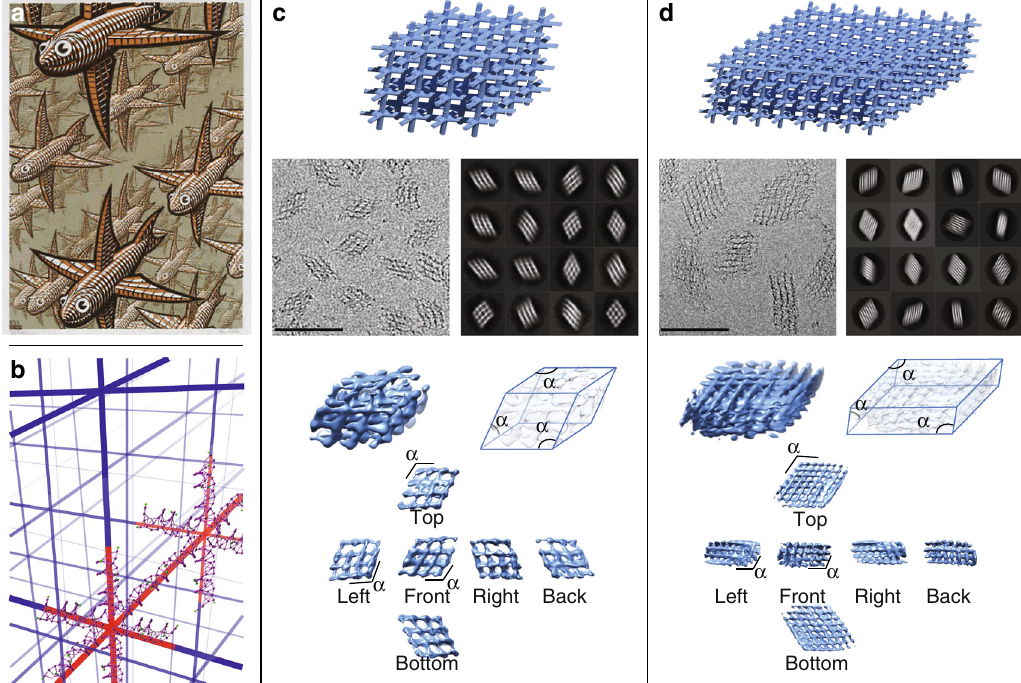
Fig. 5 Three-dimensional (3D) multi-layer arrays with 6-arm vertices. a Escher ’ s woodcut Depth . b DNA duplexes (highlighted in red) overlaid on a grid analog to Depth . c 4 × 4 × 4 array. d 8 × 8 × 4 array. Panels from top to bottom ( c and d ): Schematic diagrams; cryo-EM images (left) and examples of two- dimensional (2D) classi fi cation results (right); 3D maps, and different views of 3D electron density maps. (M.C. Escher ’ s Depth © 2019 The M.C.